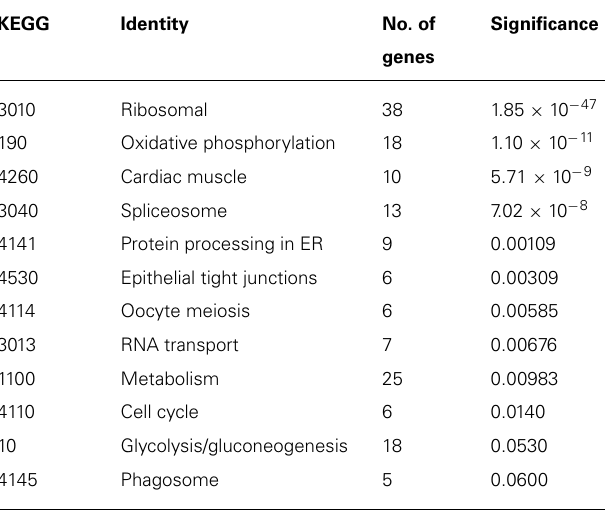
Table 1 | KEGG pathway enrichments inW98S